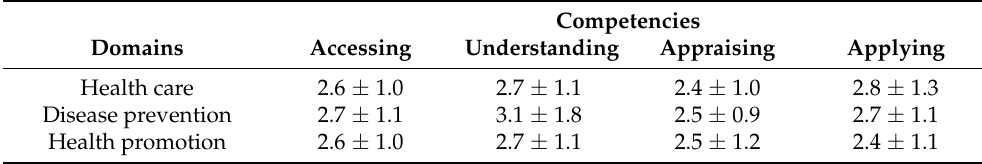
Table 3. Mean scores of each competency across the three domains of the HLS-EU-Q47.